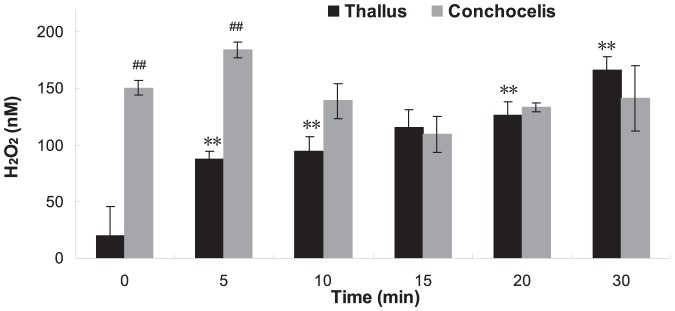
H2O2 concentrations in the medium of P. haitanensis during 30 min exposure to 35°C heat shock.